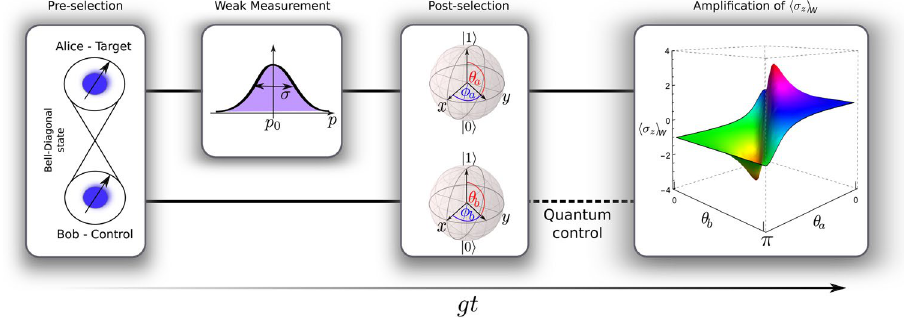
Figure 1. Model of weak measurement amplification assisted by quantum correlated